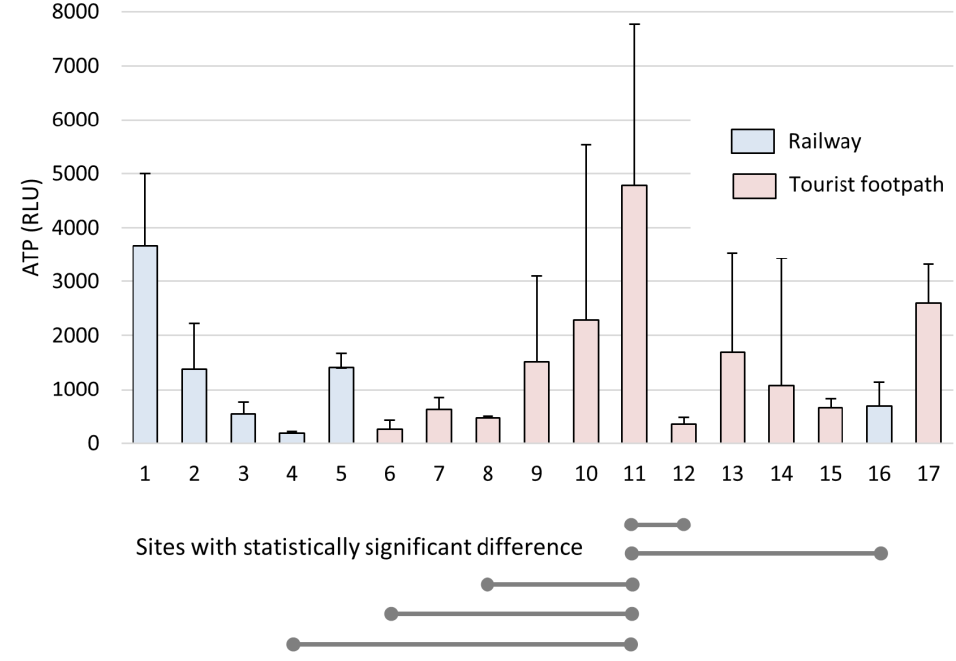
Figure 3. Airborne biomass expressed in ATP during the 7-month settling experiment per individual sites (1–17). The results are presented as the mean ATP (RLU) with SD. The lines indicate which two places were compared and showed statistically significant differences ( p < 0.05) in ATP concentrations.